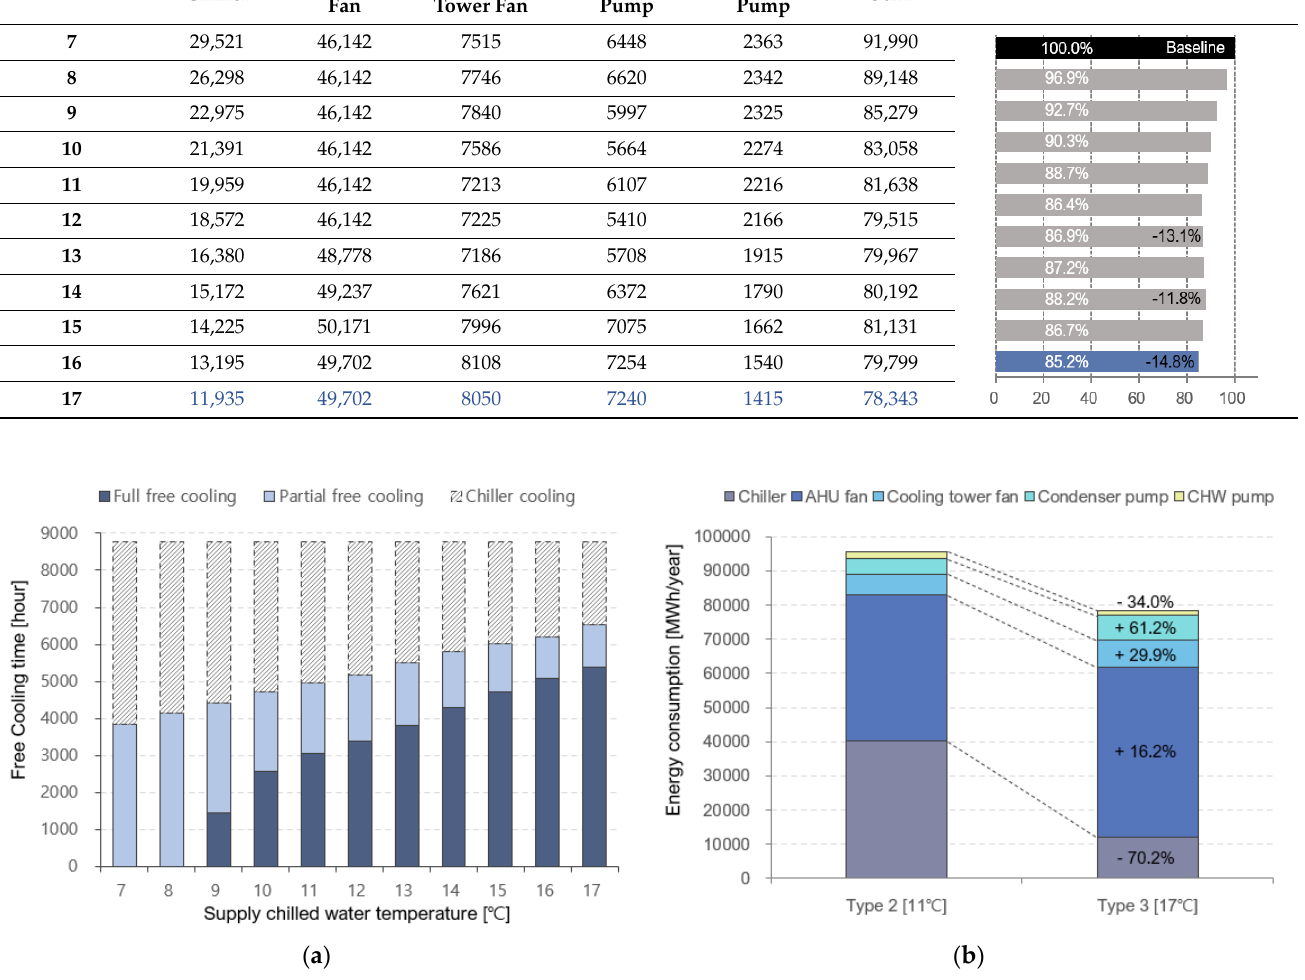
Figure 7. Free cooling time for type 3 and energy reduction for type 3 with respect to the optimal chilled water temperature for type 2. ( a ) Type 3 free cooling time, ( b ) energy saving of type 3 (17 ◦ C) compared to type 2 (11 ◦